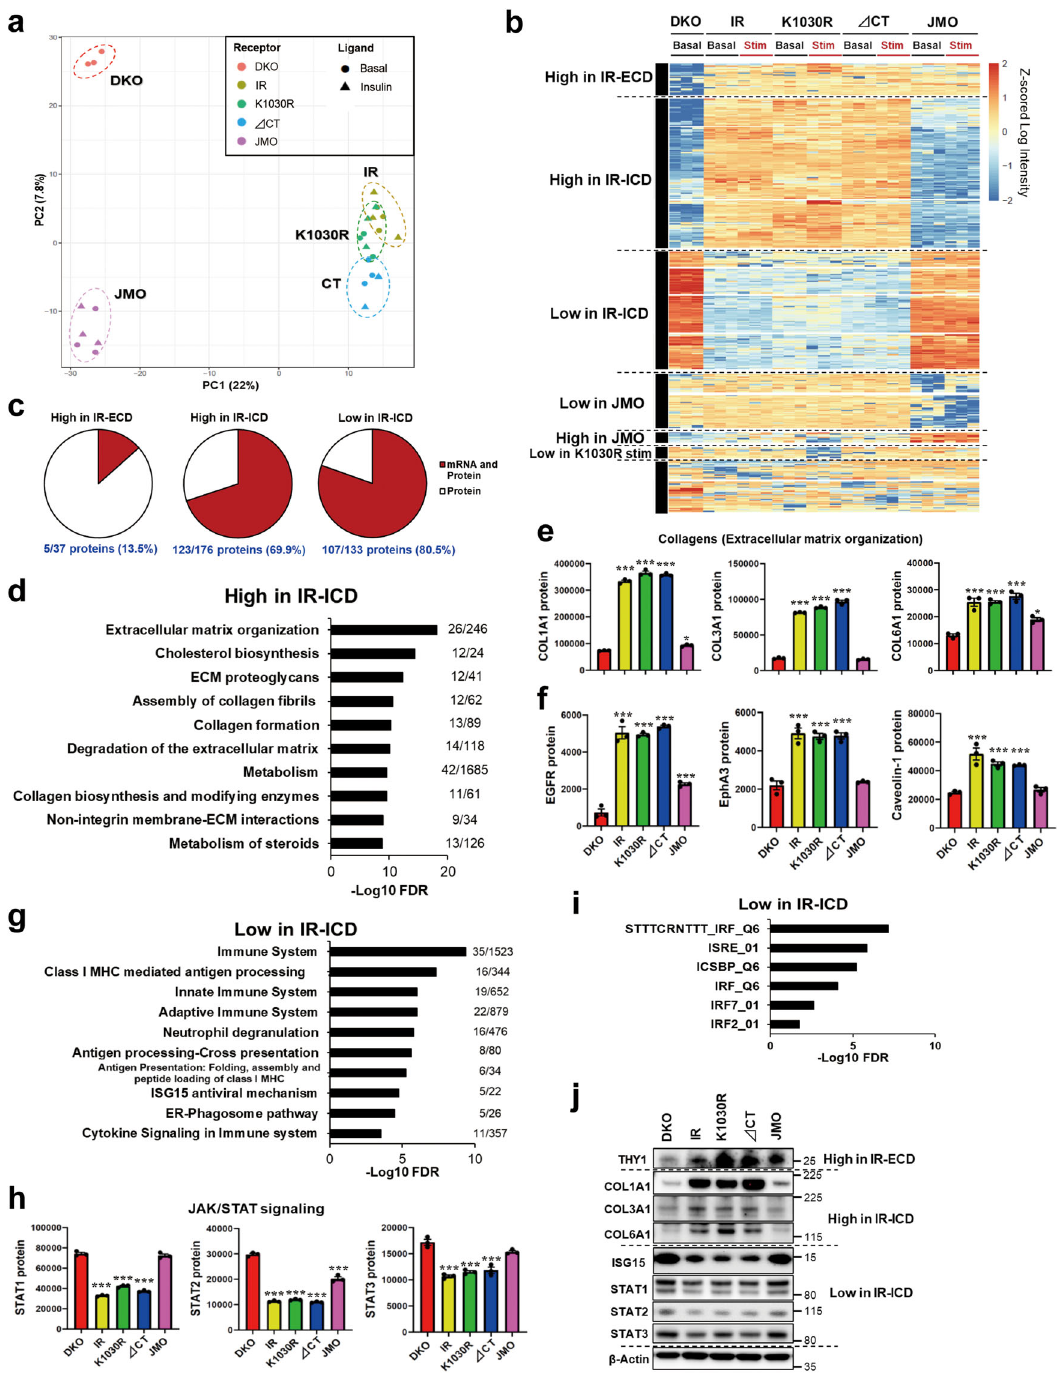
Fig. 6 | Proteomic analysis of DKO, IR,K1030R, Δ CT, and JMO cells. Analysisof IR-ICD-dependentupanddownregulatedproteins.a PCAoftheproteomefrom DKO, IR, K1030R, Δ CT,and JMO cells. Cellswereserum starved for6h with DMEM containing 0.1% BSA before 100nM insulin stimulation for 15min. b Heatmap showing thehierarchicalclustering of regulated proteins in DKO,IR, K1030R, Δ CT, and JMO cells inthe basaland insulin-stimulated states. Valuesare Z -scores of log2 transformed intensity values. c Percentage of proteins with the same changes in mRNA expressions in the high protein expression in IR-ECD, the high protein expression in IR-ICD, and the low protein expression in IR-ICD clusters. d Pathway analysisshowingthetop10REACTOMEpathwaysinthehighproteinexpressionin the IR-ICD cluster. Plots are − log10 transforms of enrichment FDR value. e Quanti fi cation of exemplary proteins of collagens from the high protein expression in IR-ICD cluster at the basal. Data are mean±SEM of protein intensity values ( n =3). * P <0.05, *** P <0.001 vs. DKO, one-way ANOVA. f Quanti fi cation of